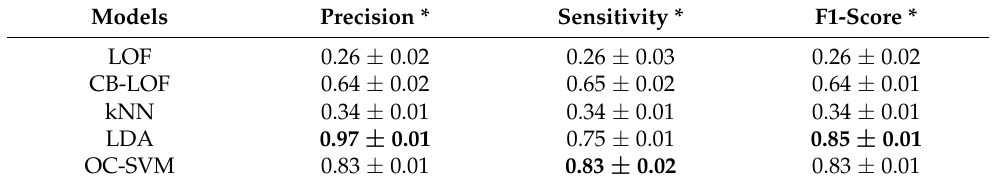
Table 3. F-score for each algorithm regarding the anomaly class. Models